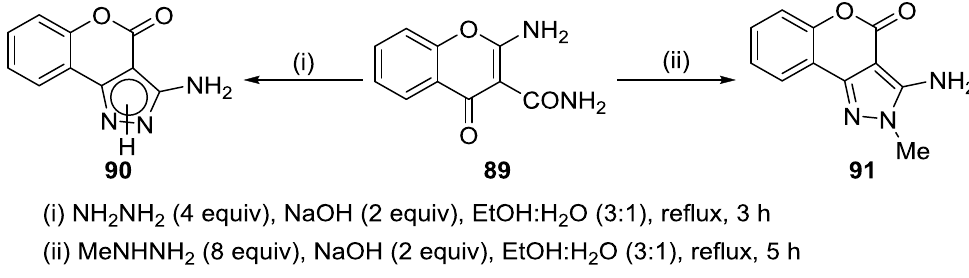
3-aminochromeno[4,3- c ]pyrazol-4-ones 90 and 91 (Scheme 28). The reaction with hydrazine afforded